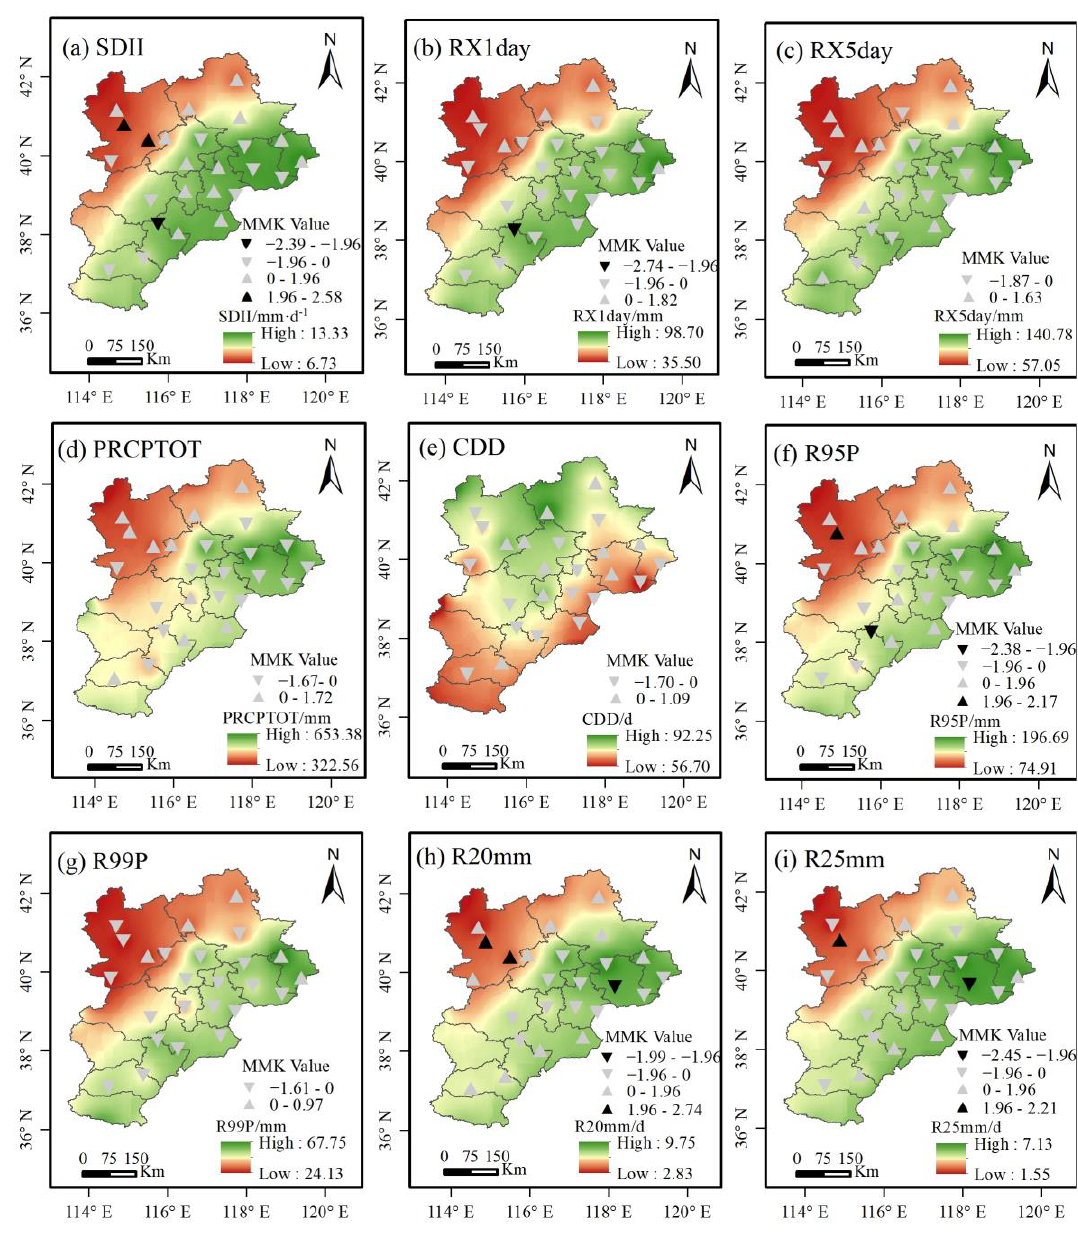
Figure 3. Spatial distribution of averaged extreme precipitation indices and trends in Beijing – Tian- jin – Hebei during 1980 – 2019 (|MMK| > 1.96 means passing 95% confidence level); (a) SDII; (b) Hebei during 1980–2019 (|MMK| > 1.96 means passing 95% confidence level); ( a ) SDII; ( b ) RX1day; RX1day; (c) RX5day; (d) PRCPTOT; (e) CDD; (f) R95P; (g) R99P; (h) R20mm; (i) R25mm. ( c ) RX5day; ( d ) PRCPTOT; ( e ) CDD; ( f ) R95P; ( g ) R99P; ( h ) R20mm; ( i ) R25mm.